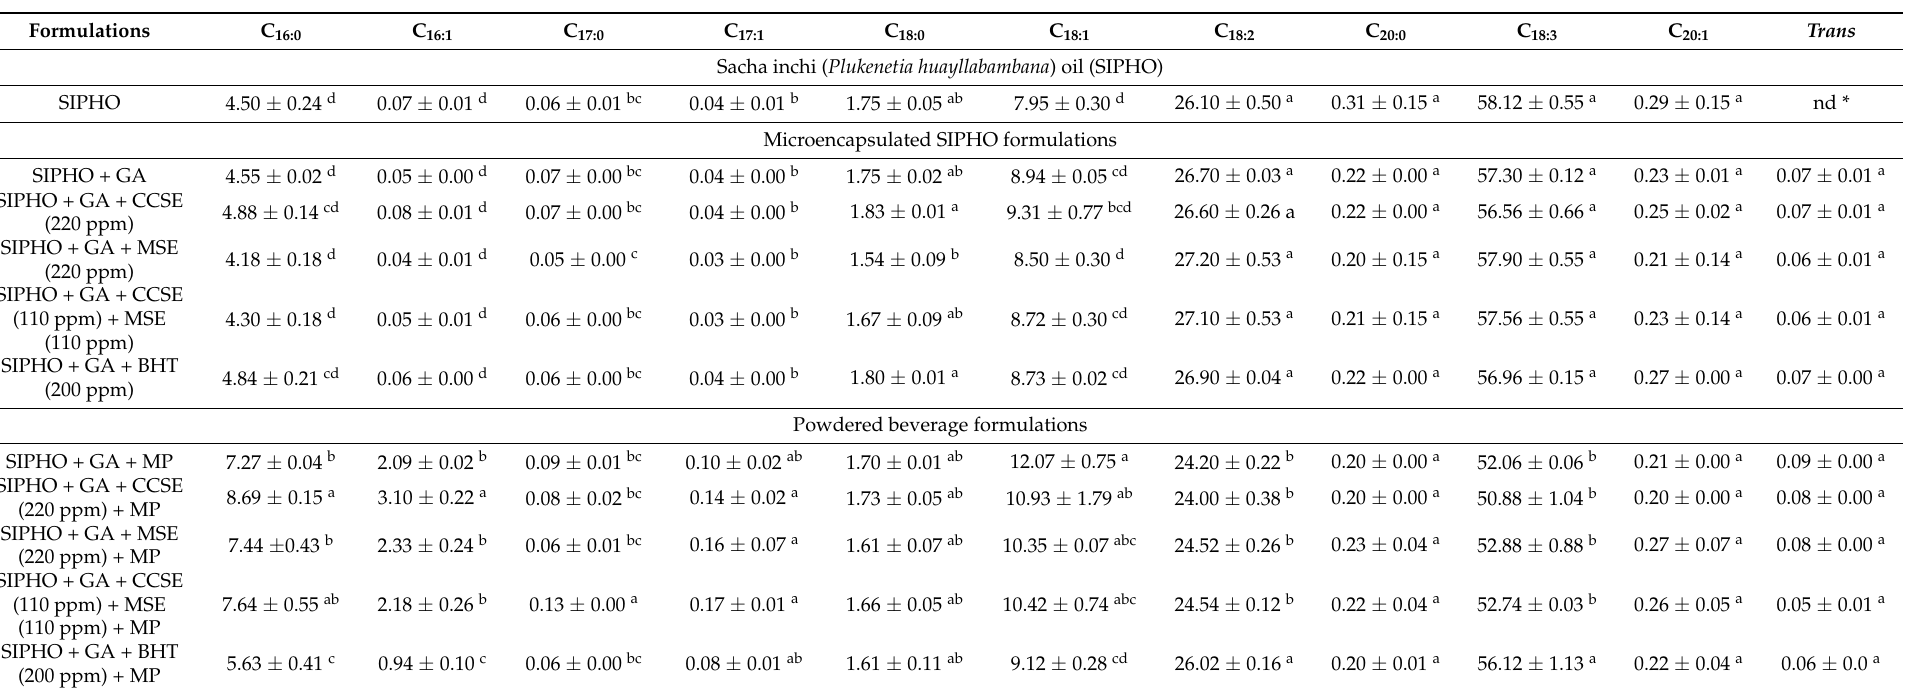
Table 3. Composition in fatty acids (%) of total oil extracted from sacha inchi ( P. huayllabambana ) (SIPHO) microencapsulated and powdered beverage